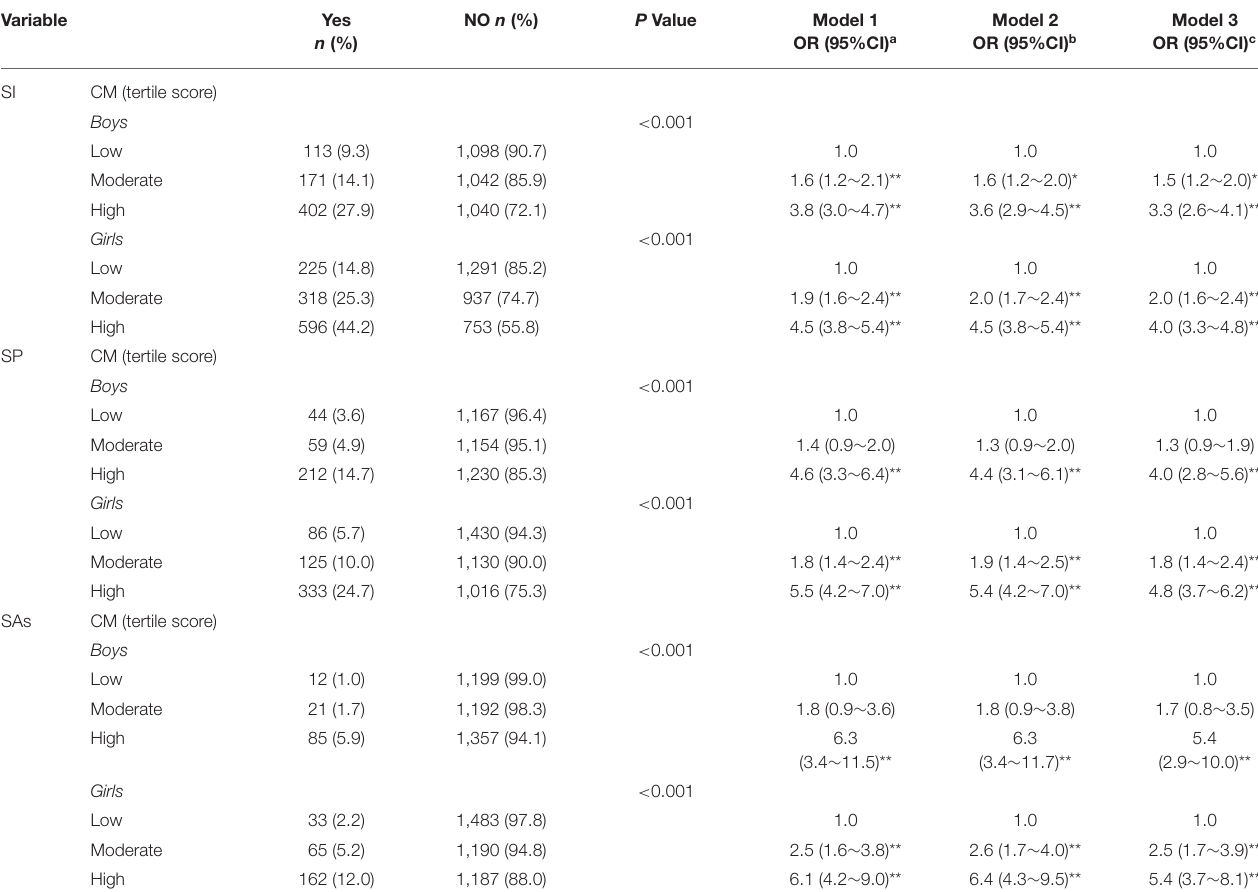
TABLE 2 | Number, % and OR of suicidal behaviors by level of CM in boys and girls.